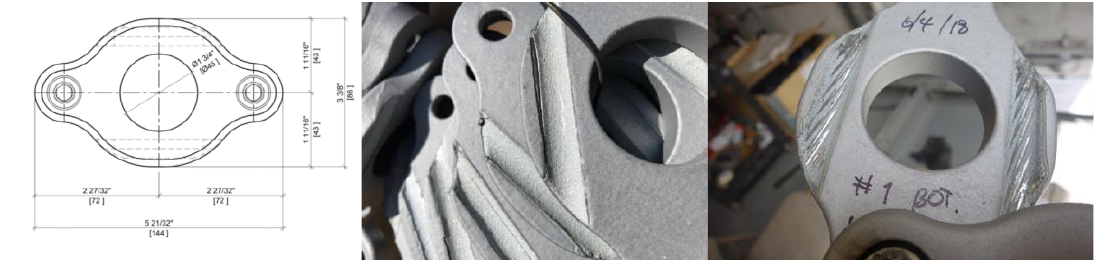
Figs. 25, 26, 27 Drawing of a cable clamp (left), fabricated pieces with special zinc coating in the notched steel (center), and tested clamp assembly with visible traces of the cable wires (right). All images: Knippers Helbig.